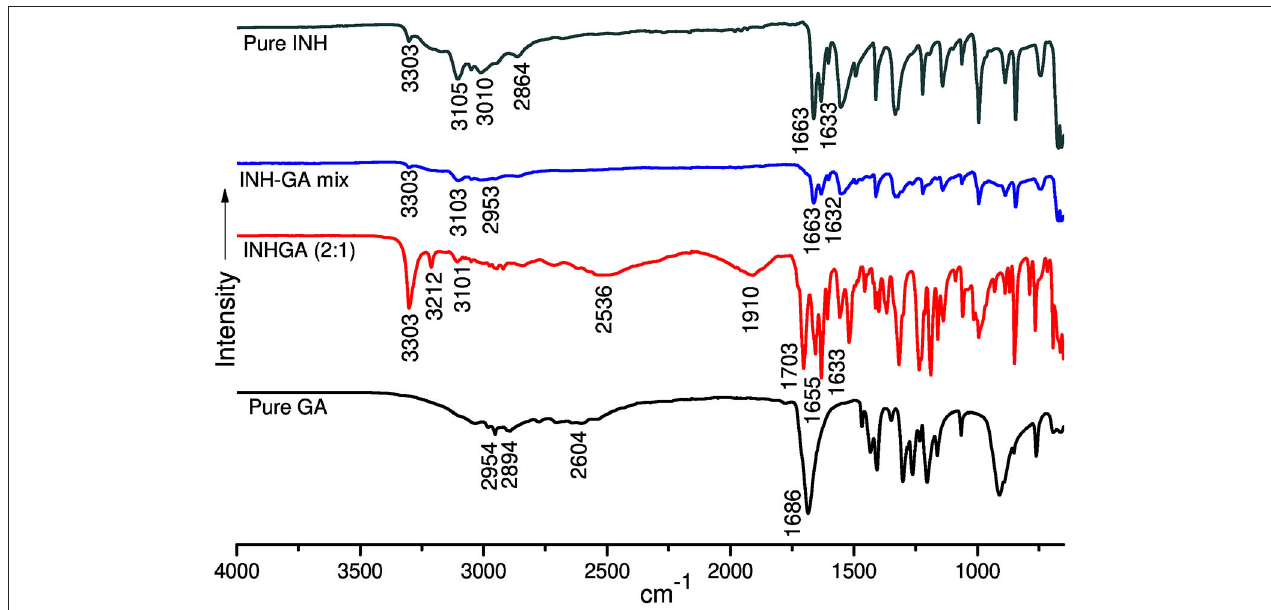
FIGURE 4 | The FTIR spectra of isoniazid (INH), pentanedioic acid (GA), and INH-GA as a physical mixture and the (2:1) co-crystal.